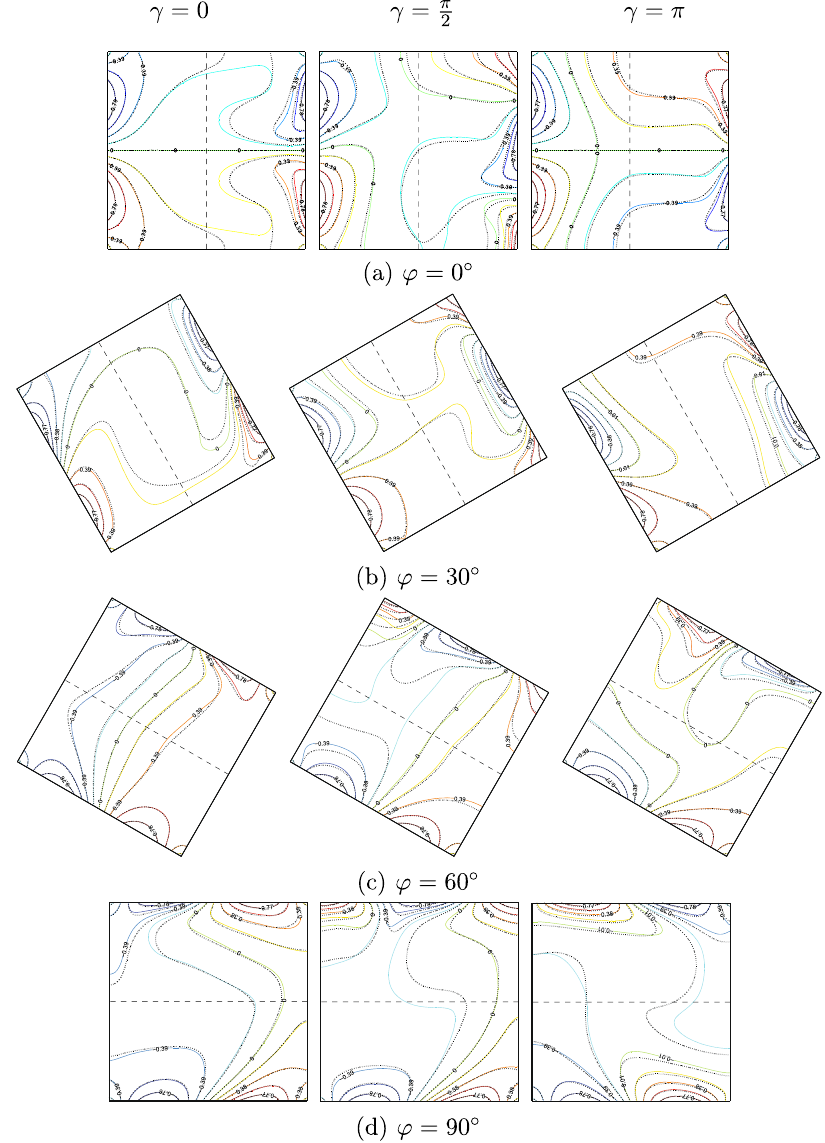
Figure 9. Isotherms evolution by ϕ and γ for Ra bf = 10 5 , Da = 10 − 4 , ε = 1, S = 0.5, φ = 0 (solid lines) and φ = 0.1 (dashed